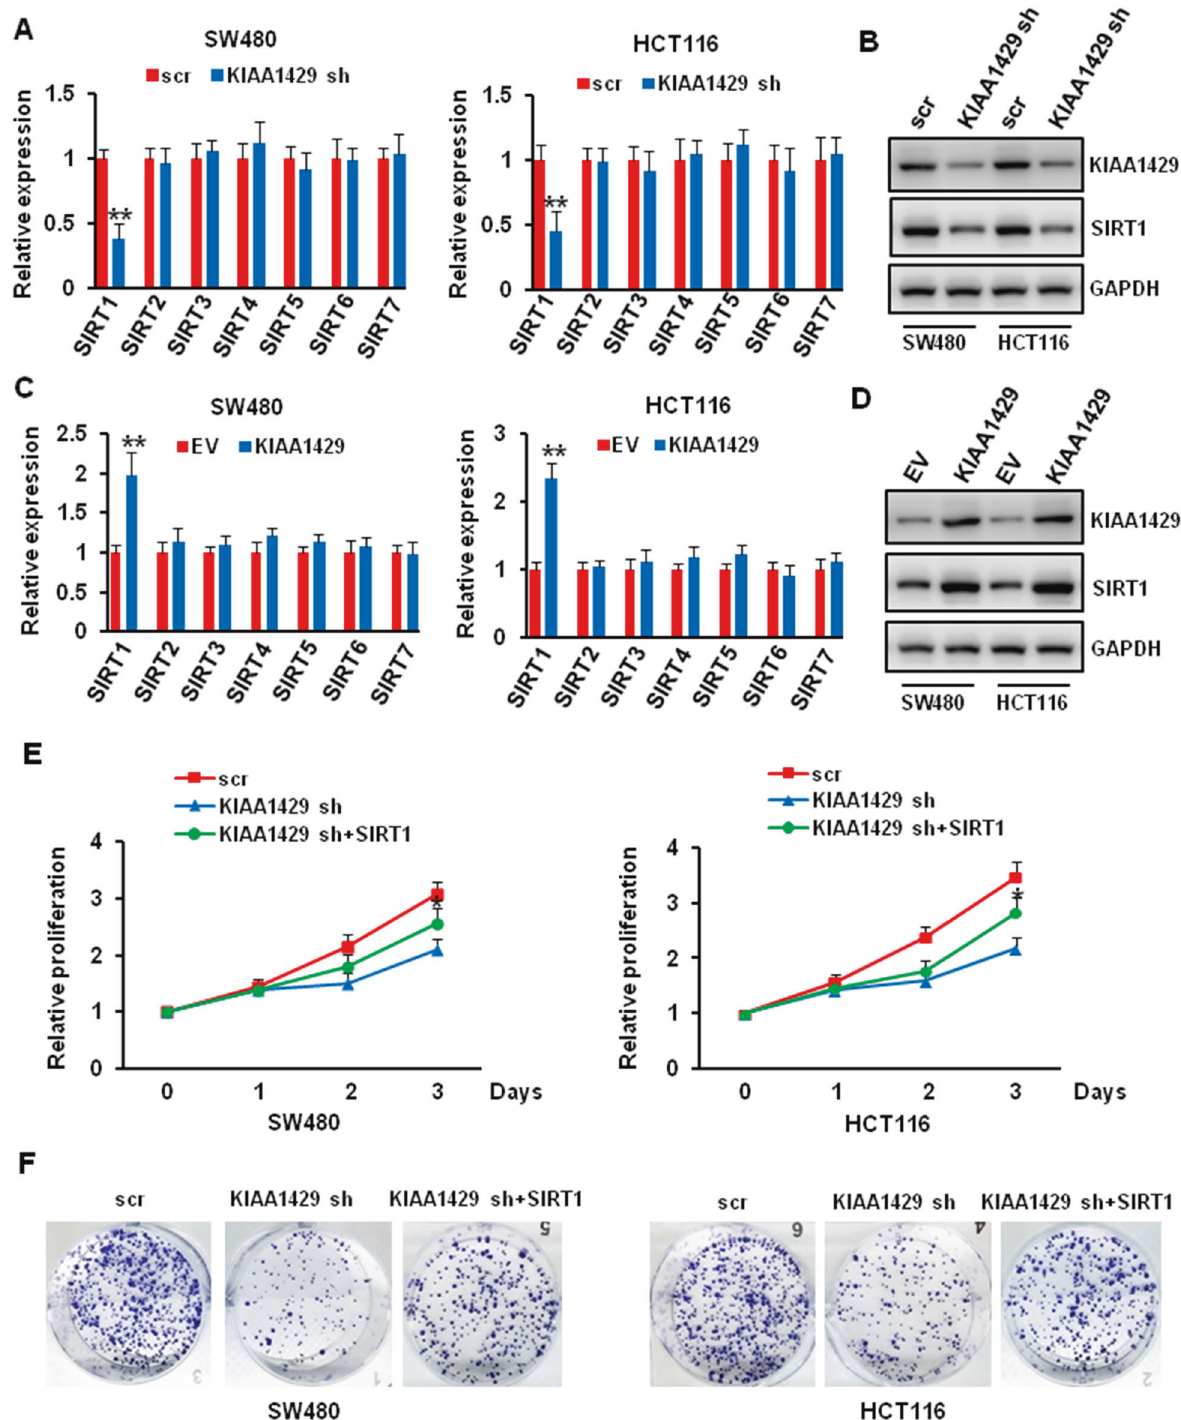
Fig. 5 Effect of KIAA1429 on regulating the expression of SIRT1. A , B SW480 and HCT116 cells were infected with scr and KIAA1429 shRNA, the mRNA and protein level of SIRTs were detected by QRT-PCR ( A ) and western blotting ( B ). ** P < 0.01. C , D SW480 and HCT116 cells were transfected with empty vector (EV) and KIAA1429 plasmid, the mRNA and protein level of SIRTs were detected by QRT-PCR ( C ) and western blotting ( D ). ** P < 0.01. E The proliferation of SW480 and HCT116 cells after KIAA1429 depletion followed with or without SIRT1 overexpression was measured using CCK- 8 assay. * P < 0.05. F The growth of SW480 and HCT116 cells over 14 days after KIAA1429 depletion followed with or without SIRT1 overexpression was measured using colony formation assay. Colony formation assay CCK8 reagent was added to each well at the indicated time and Thousand colorectal cancer cells were seeded into each well of a 6-well incubated at 37 °C for 2 h. The absorbance at 450 nm was recorded with plate after being infected with KIAA1429 shRNA or transfected with a 96-well plate reader.